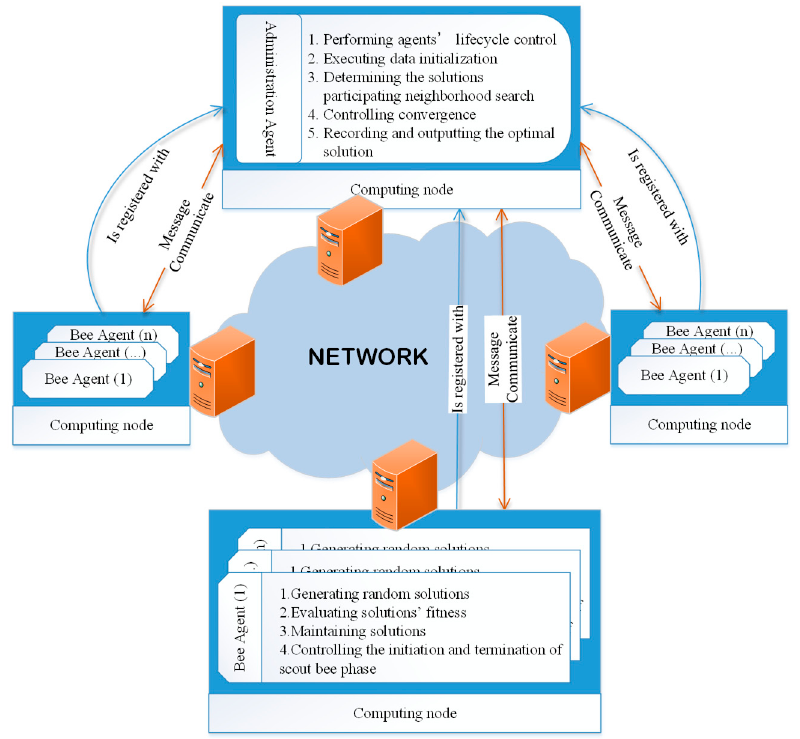
Figure 2 Agents’ role design. Figure 2. Agents’ role